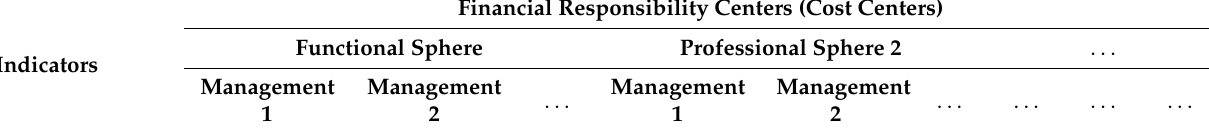
Table 3. The proposed form of the register “Structure of expenses (costs) by financial responsibility centers (cost